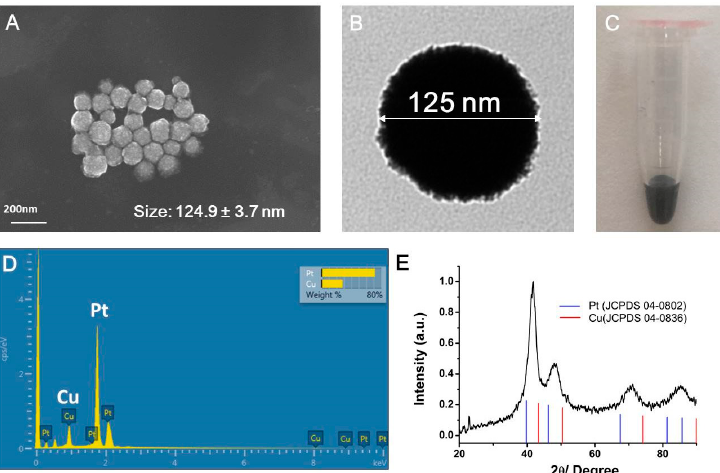
Figure 1. Characterizations of the nanocomposite consisting of Cu and Pt (CuPt). ( A ) Scanning Electron Microscope (SEM) image of CuPt, ( B ) Transmission electron microscope (TEM) image. ( C ) Photo of CuPt solution. ( D ) Energy-dispersive X-ray (EDX) images for CuPt. ( E ) Powder X-ray diffraction (XRD) pattern of CuPt.